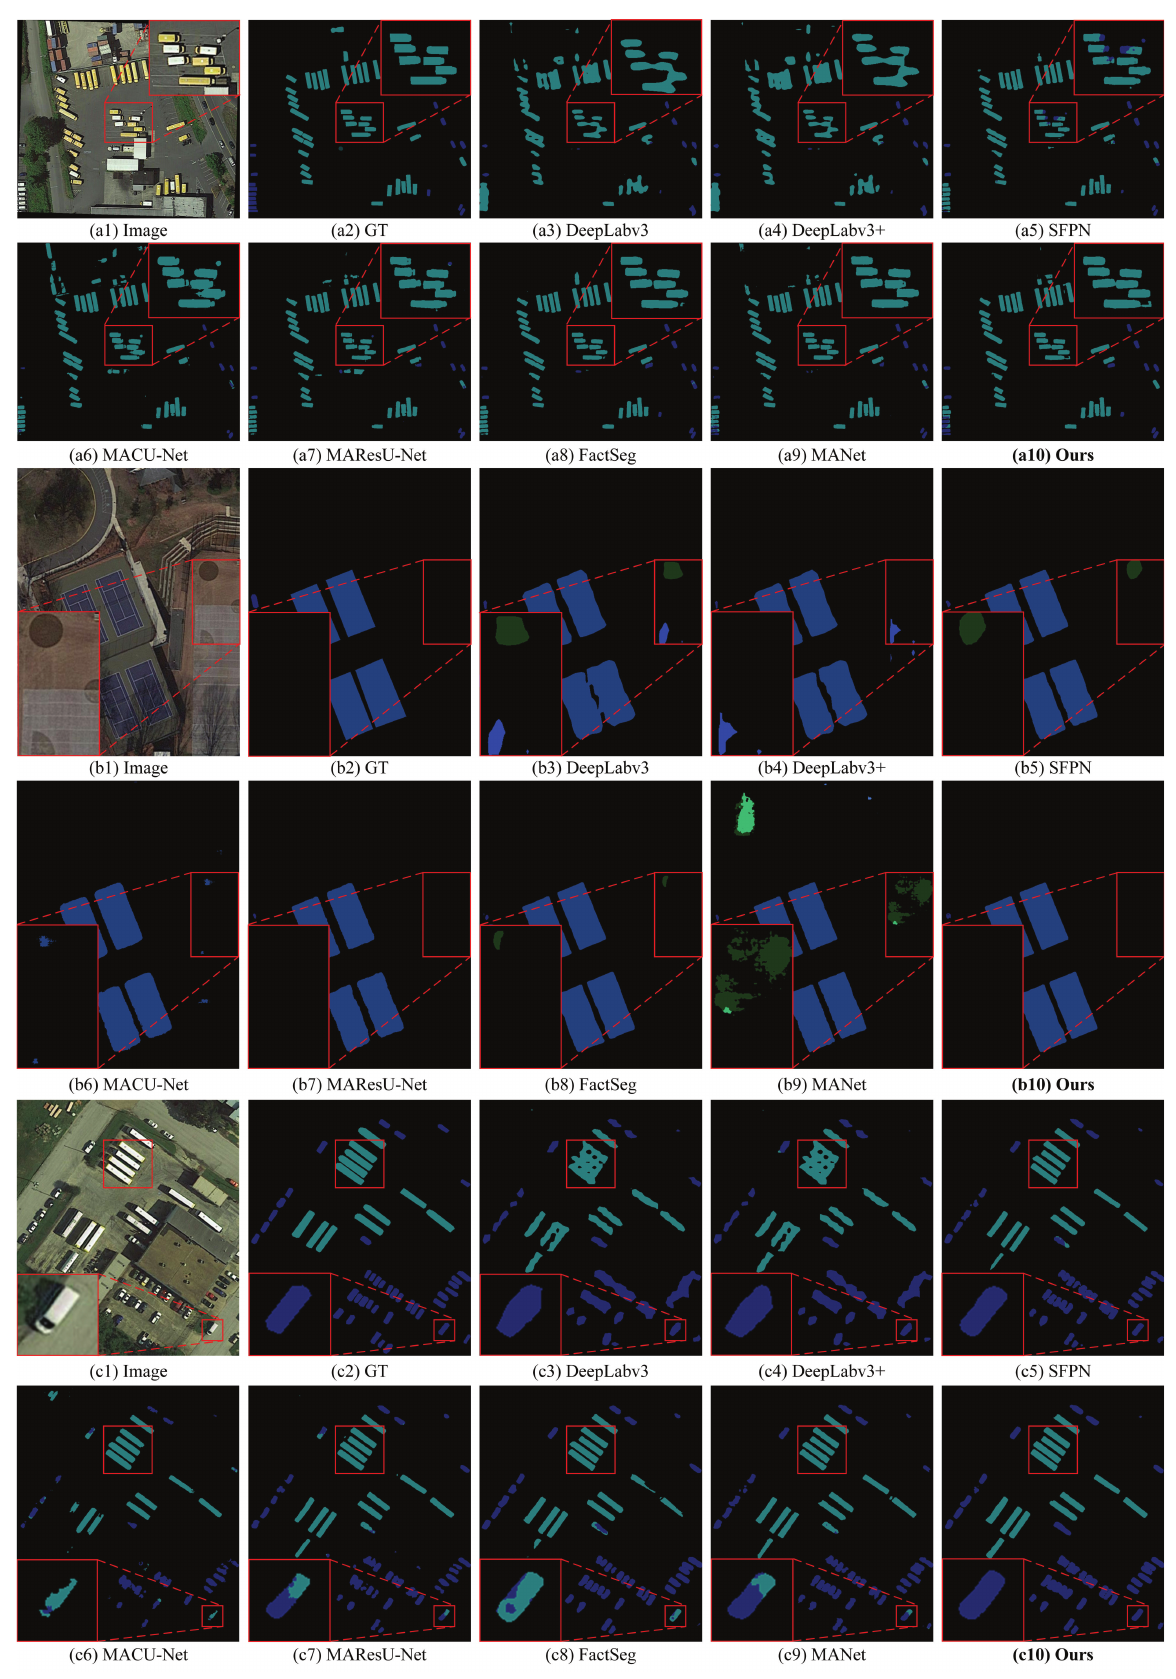
Figure 5. The visualization results of the proposed PGNet and SOTA methods on the iSAID